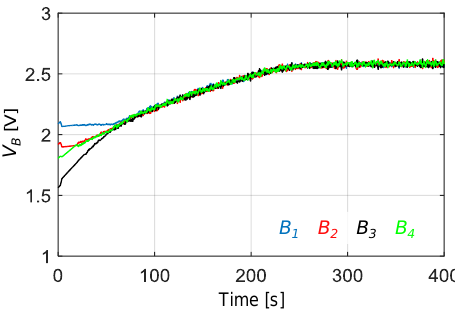
Figure 18. Measured EDLC cell voltage, charged by the CC-CV charger with the string-to-cells balancer.